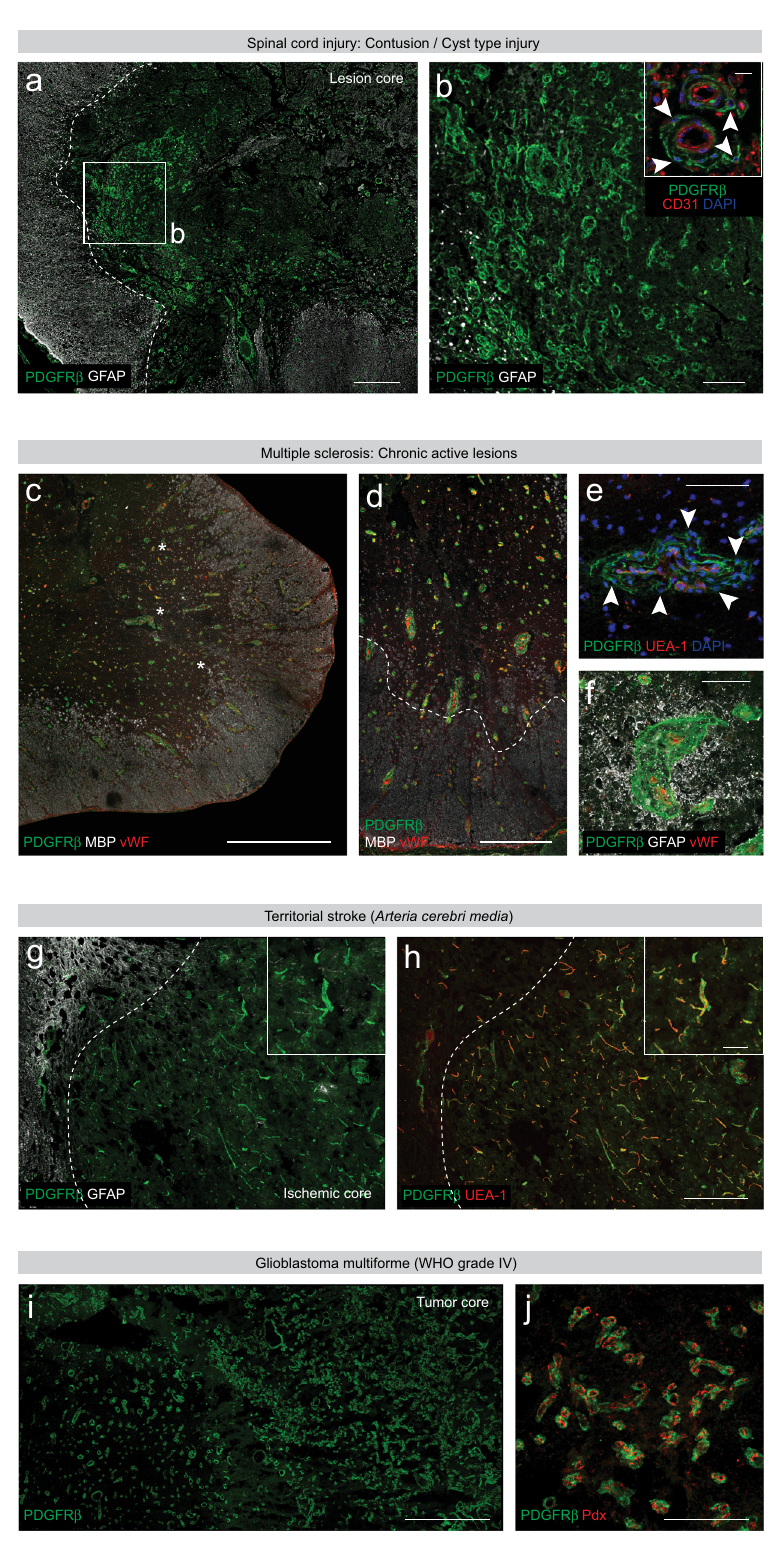
fl uorescent myelin stain (1:500, Invitrogen, F34652). For collagen type I and fi bronectin immunolabeling, heat-induced antigen retrieval was performed in citrate buffer (10mM sodium citrate, 0.05% Tween 20, pH 6.0) for 5min in a domestic steamer. The sections were allowed to cool down for 20min before commencing the immunostaining. The following primary antibodies were used to immunostain human tissue: PDGFR β (1:100, goat, R&D Systems), GFAP (1:200, rabbit, Dako; 1:1000, chicken, Millipore), MBP (1:500, rat, AbD Serotec; 1:1000, mouse, Covance), CD31 (1:100, mouse, Dako), podocalyxin (1:200, goat, R&D Systems) and von Willebrand factor (1:200, rabbit,